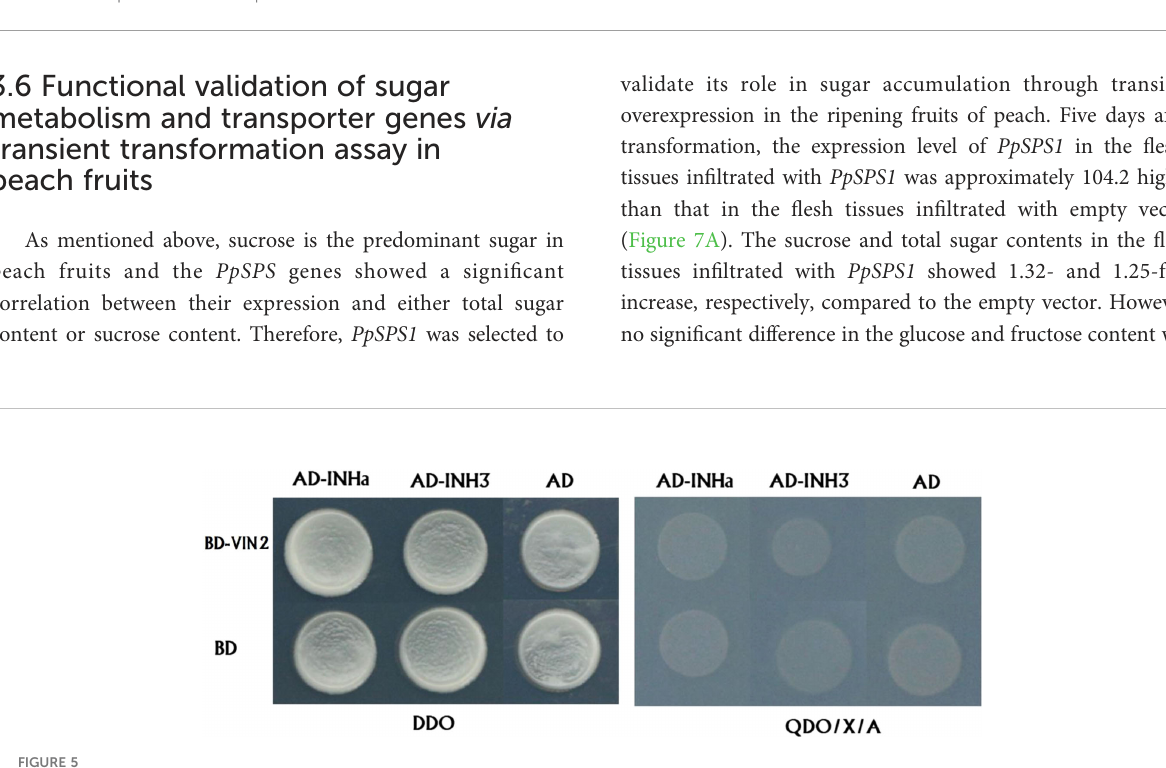
FIGURE 4 Subcellular localization of PpINHa, PpINH3 and PpVIN2 in tobacco leaves. Co-expression of psuper1300GFP-PpINHa, psuper1300GFP-PpINH3 or psuper1300GFP-PpVIN2 with tonoplast marker RFP in bright fi eld, GFP channel, mCherry channel, and merged channel, respectively. The scale bars represent 25 or 50